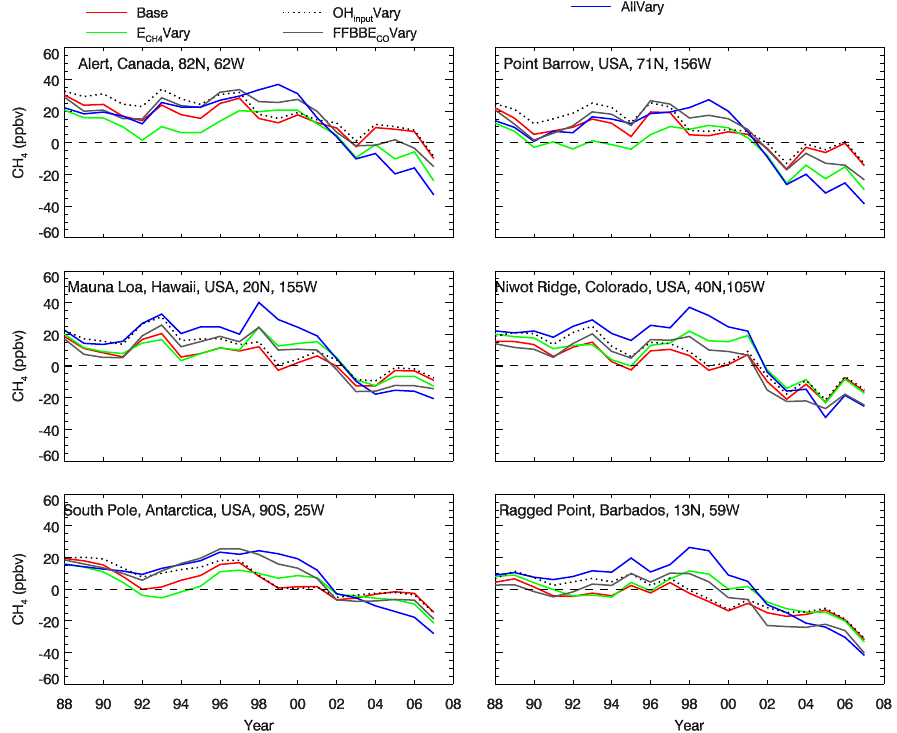
Figure 7. Annual methane deviation (ppbv; simulated–measured) for several scenarios and observations at six GMD stations.